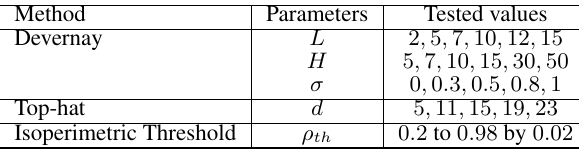
Table 1. Parameters tested for each method. .